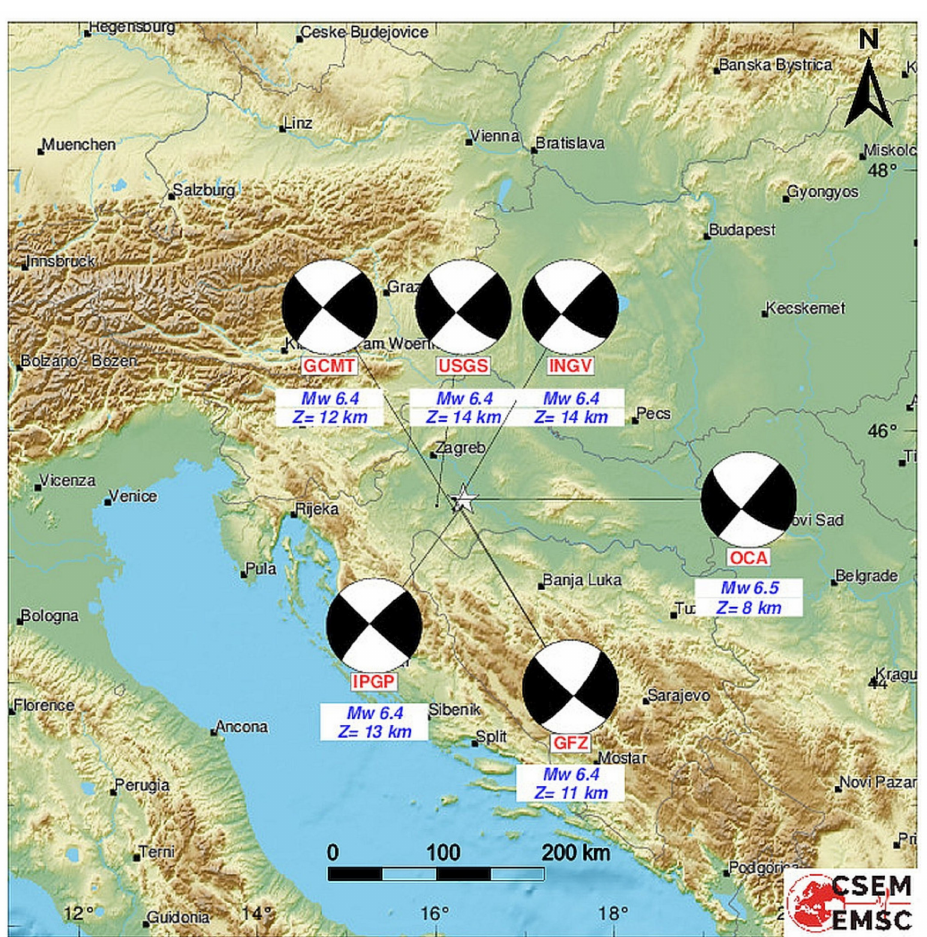
Figure 4. Quick moment tensor solutions of the M6.2 mainshock on 29 December 2020 at 11:19 UTC (source: CSEM–EMSC